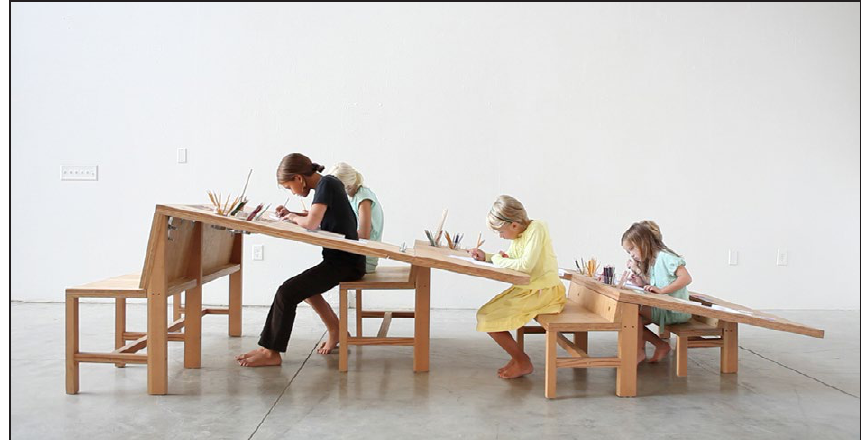
Figure 31: Iris Anna Regn and Tim Durfee, Growth Table, Marine plywood, Douglas fir, glass, rubber, drawing supplies, 2009 (Photo by Jeremy Eichenbaum).